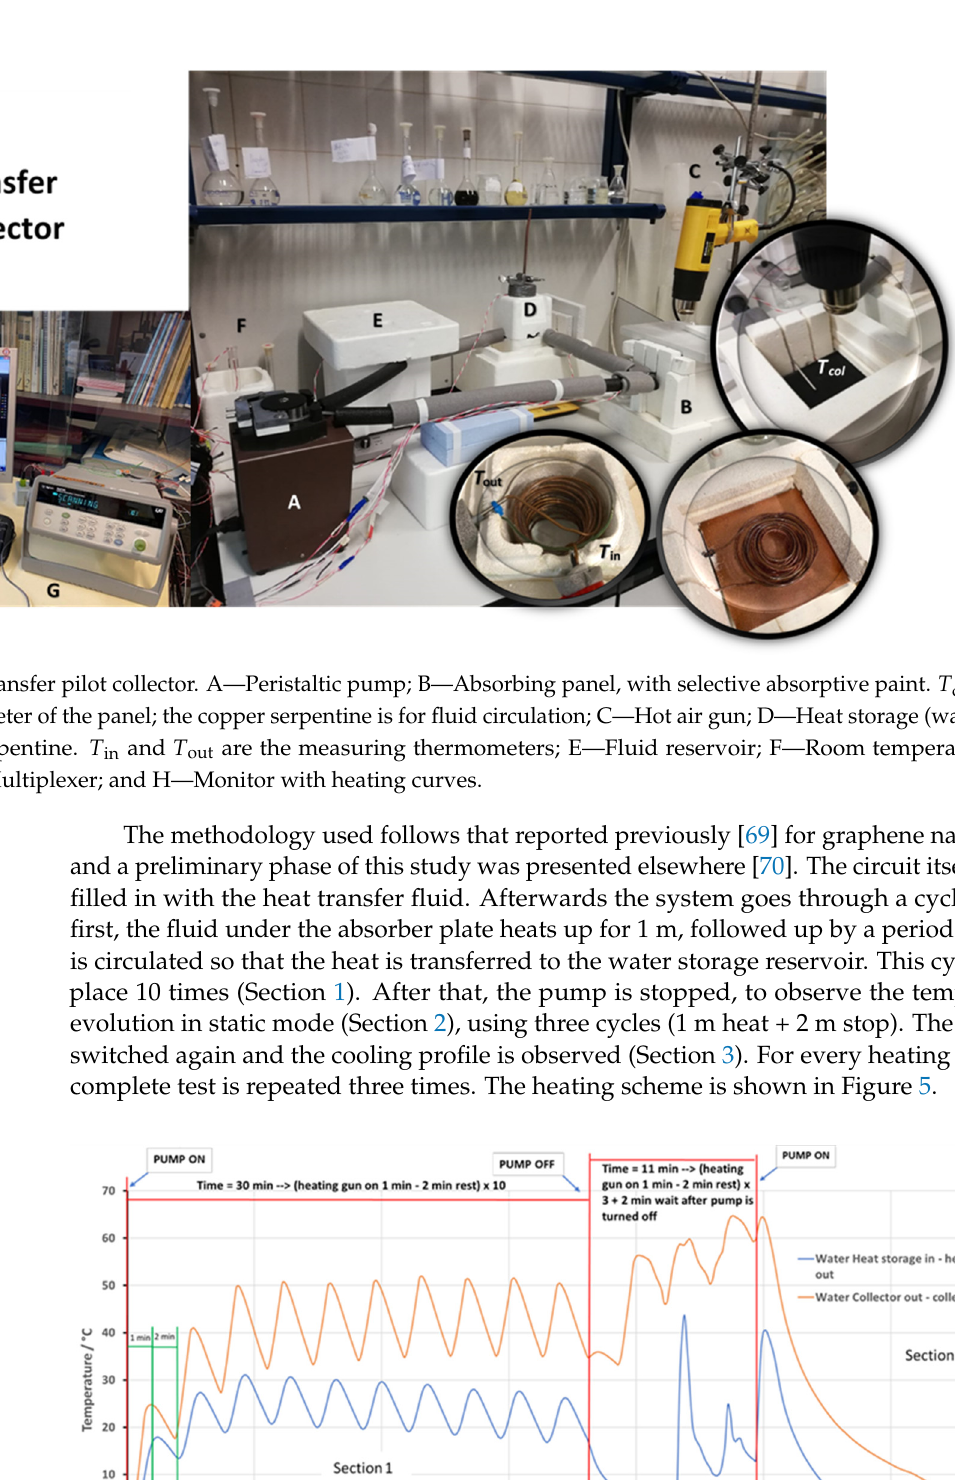
Figure 3. SEM images of melanin and TiO 2 nanoparticles used in this work. ( a – d ), for melanin; ( e , f ) for TiO 2 . Explanation